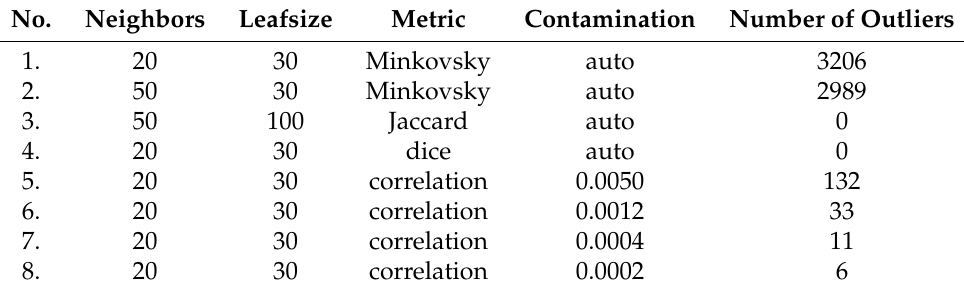
Table 3. Parameters of the LOF algorithm and number of outliers detected in the D